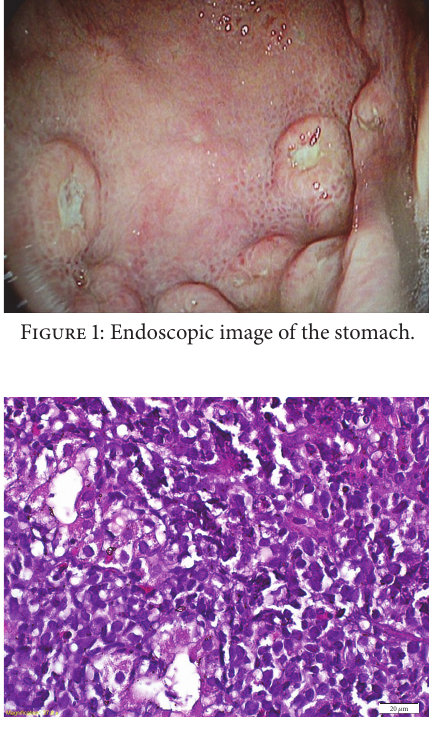
Figure 2: Pathology of the